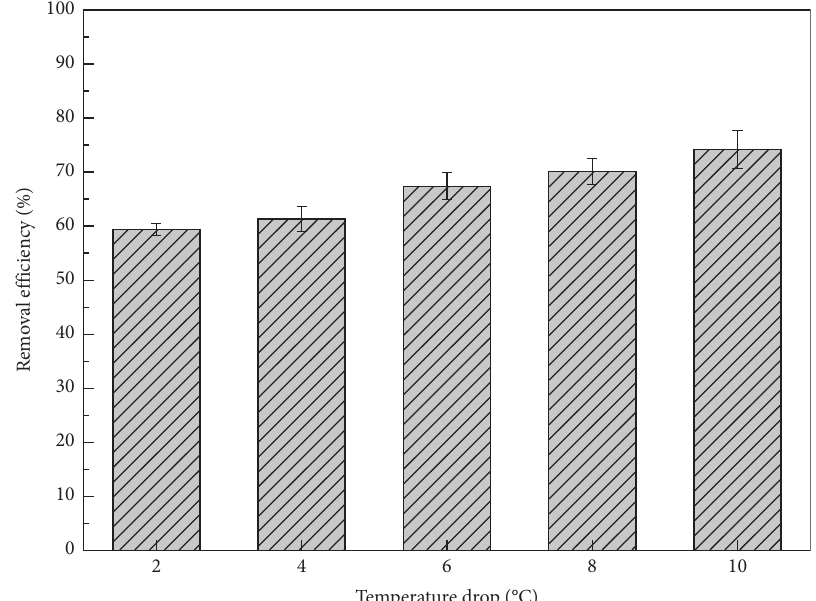
Figure 6: Effect of temperature drop on the removal efficiency of sulfuric acid